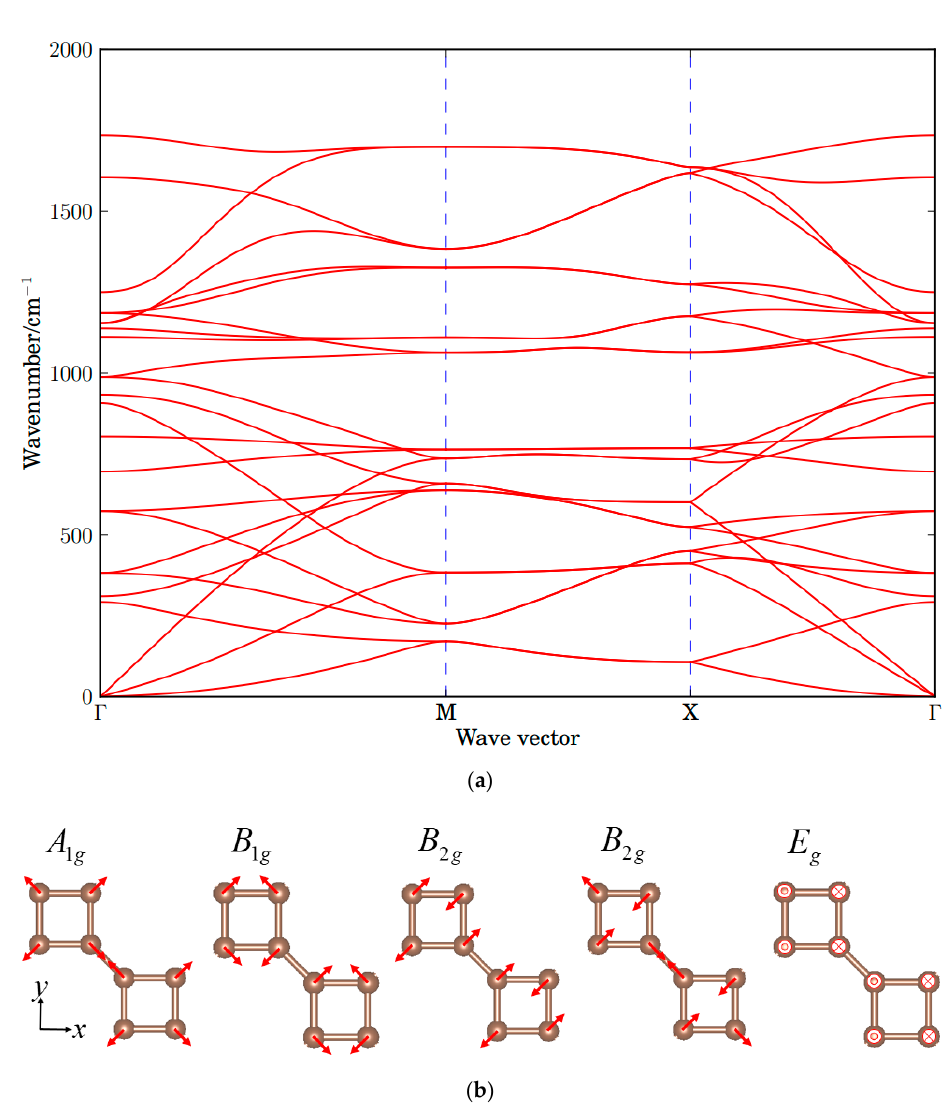
Figure 3. ( a ) Phonon dispersions of the octagon ‐ structure carbon monolayer, ( b ) Raman active modes A 1g (in ‐ plane), B 1g (in ‐ plane), B 2g (in ‐ plane) and E g (out ‐ of ‐ plane) at Γ point. The dot and cross on the atoms refer to displacement in and out of the plane, respectively, and the red arrows refer to the in ‐ plane displacement. The length of the arrows is nonphysical. In order to calculate the Raman intensity, we chose three commonly used laser lines whose wavelengths are 488 nm (2.54eV), 532 nm (2.33eV) and 633 nm (1.96eV) [27,30]. The coordinate system is chosen so that the monolayer plane is in the x ‐ y plane. The calculated results show that the Raman tensors agree with the point group D 4h and their irreducible representations. They are the following matrix forms: